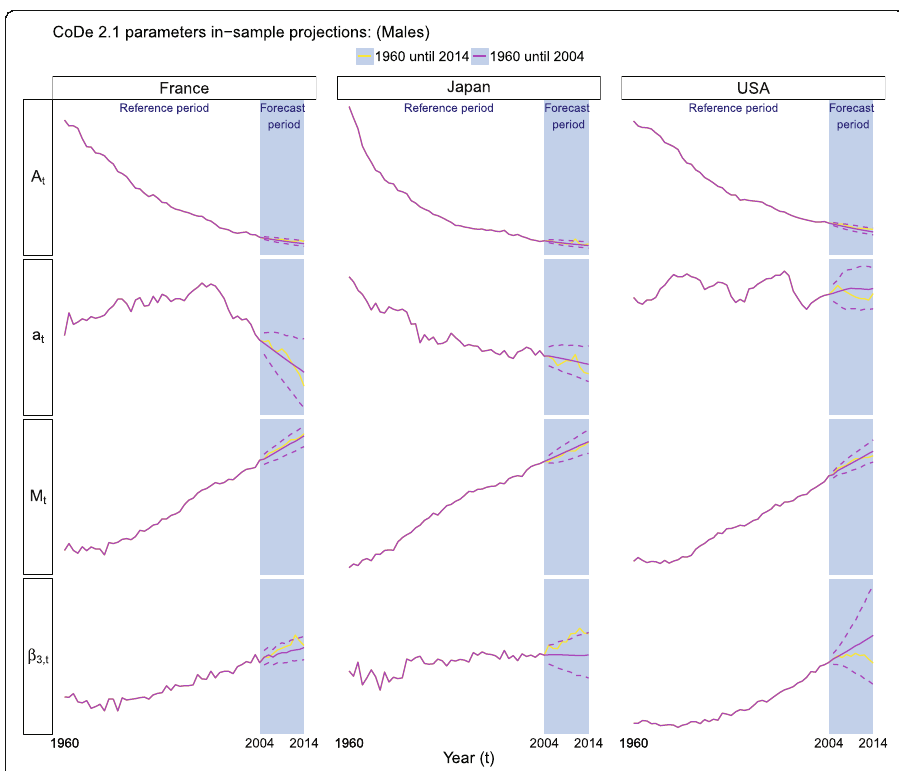
Fig. 14 Estimation and in-sample projections of CoDe 2.1 model parameters of males. The reference period is 1960 – 2004 (white); the projection period is 2005 – 2014 (blue)